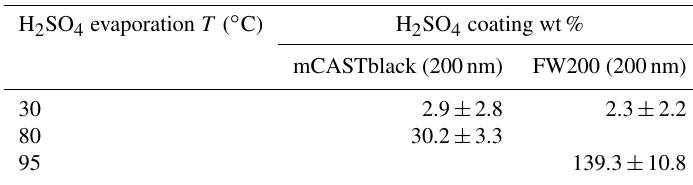
Figure 3. The mobility diameter, calculated effective density and the number of equivalent H 2 SO 4 coating monolayers of mCASTblack 200 (a) and 400nm (b) and FW200 200 (c) and 400nm (d) . Table 2. The ratio of coated H 2 SO 4 mass to the bare soot particle mass (wt%) for 200nm mCASTblack and FW200 soot aggregates collected for TEM analysis. The uncertainty represents 1 standard